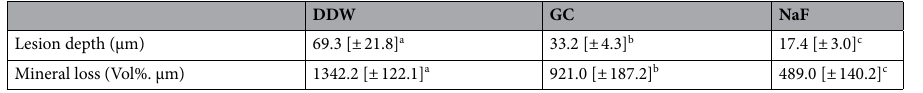
Table 3. The estimated mineral loss and lesion depth after pH cycling (Mean [± SD]). Different superscript letters indicate a significant difference between groups (p < 0.05). DDW samples treated with double distilled water, GC samples treated with GERM CLEAN, NaF samples treated with 1000 ppm